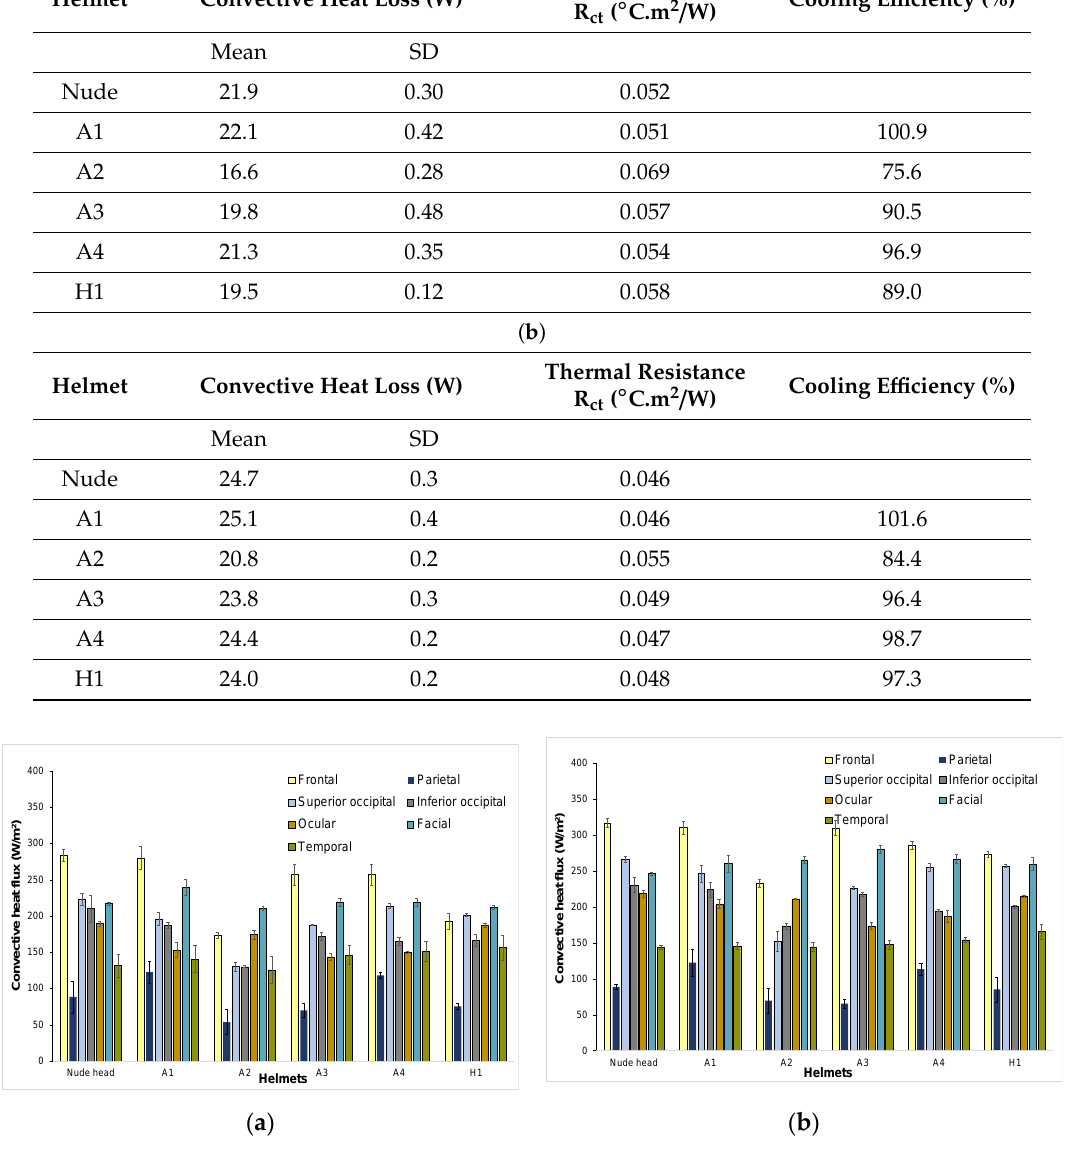
Figure 6. Zonal convective heat-flux distribution at ( a ) 3 m/s; ( b ) 6 m/s.